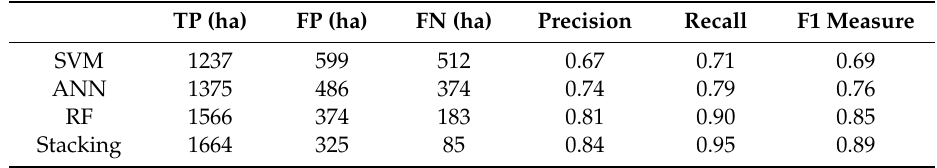
Table 2. The quantitative accuracy assessment of applied machine learning (ML) models in gully networks